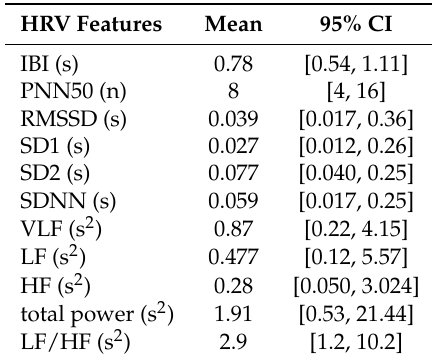
Table 2. Descriptive statistic of hart rate variability (HRV) features. Mean and 95% coefficient intervals (CI) are provided for all the feature.